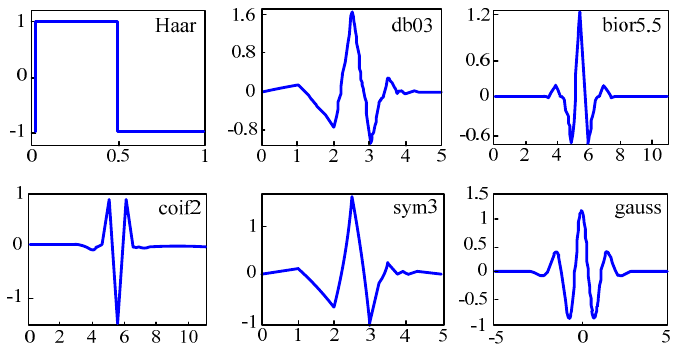
Figure 8. Examples of wavelet families.